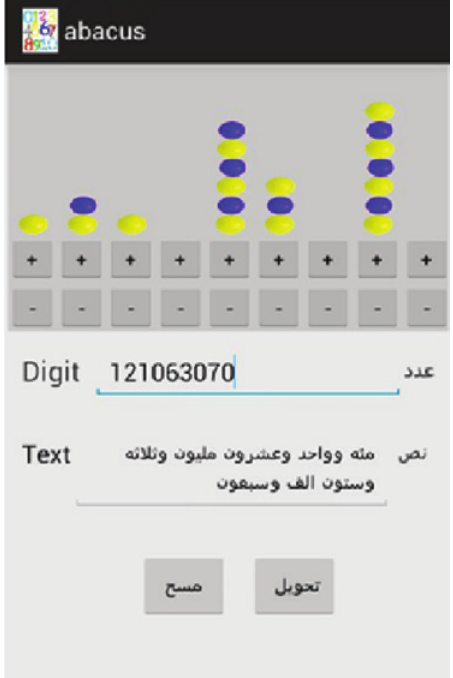
Figure 3: The Abacus Application with a Given